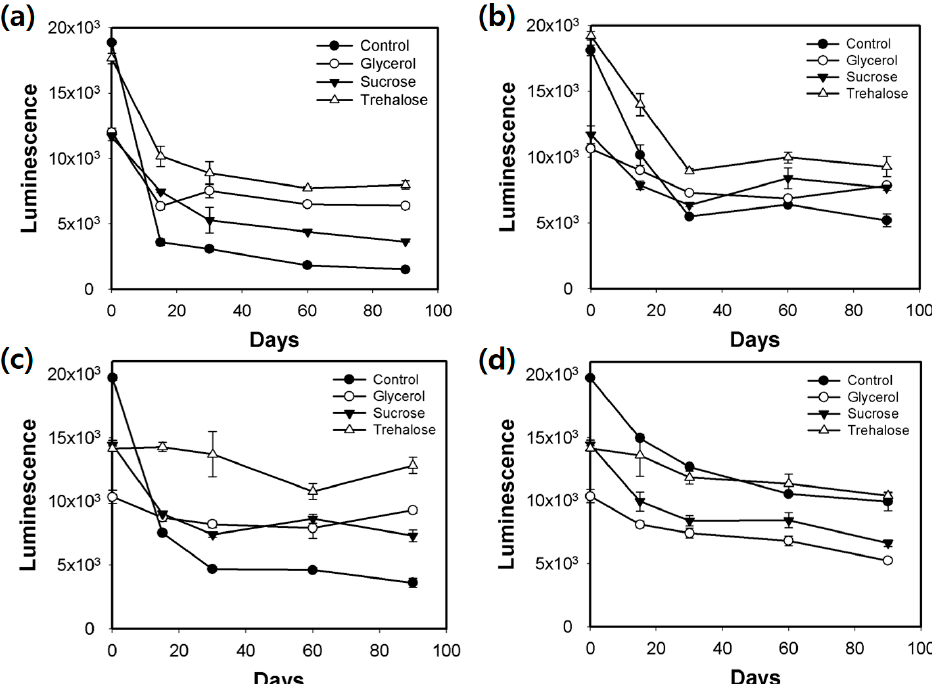
Figure 4. Luminescence intensities of the amino acid array containing carbohydrate-type cryoprotectants (5%) during the long-term storage period (3 months) under the following conditions: ( a ) agarose immobilization at − 20 ◦ C, ( b ) agarose immobilization at − 80 ◦ C, ( c ) without agarose immobilization at − 20 ◦ C, and ( d ) without agarose immobilization at − 80 ◦ C. Error bars represent standard errors derived from three independent measurements.